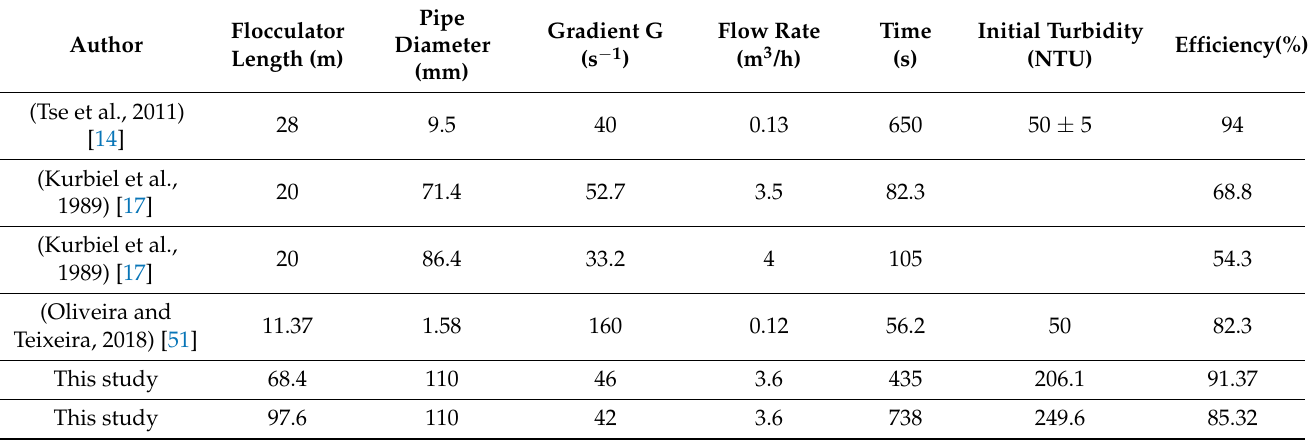
Table 17. Characteristics of the HTF used in other